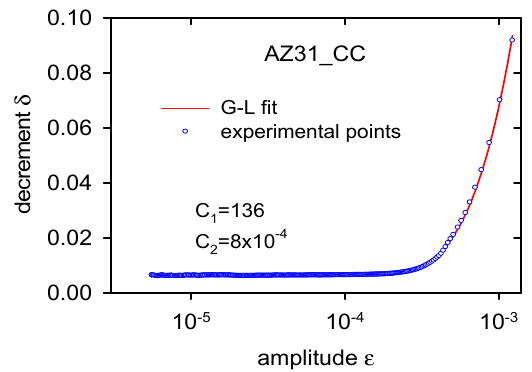
Figure 9. G-L fit for the curve measured after thermal cycling up to 200 °C.